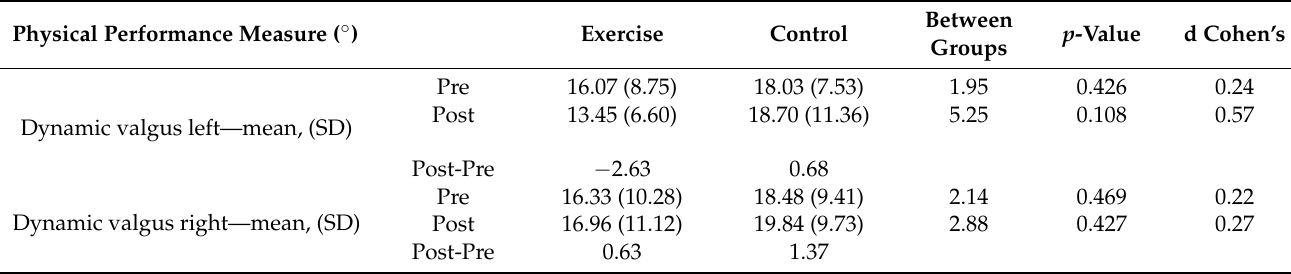
Table 3. Comparison within-group and between group for the dynamic knee valgus.